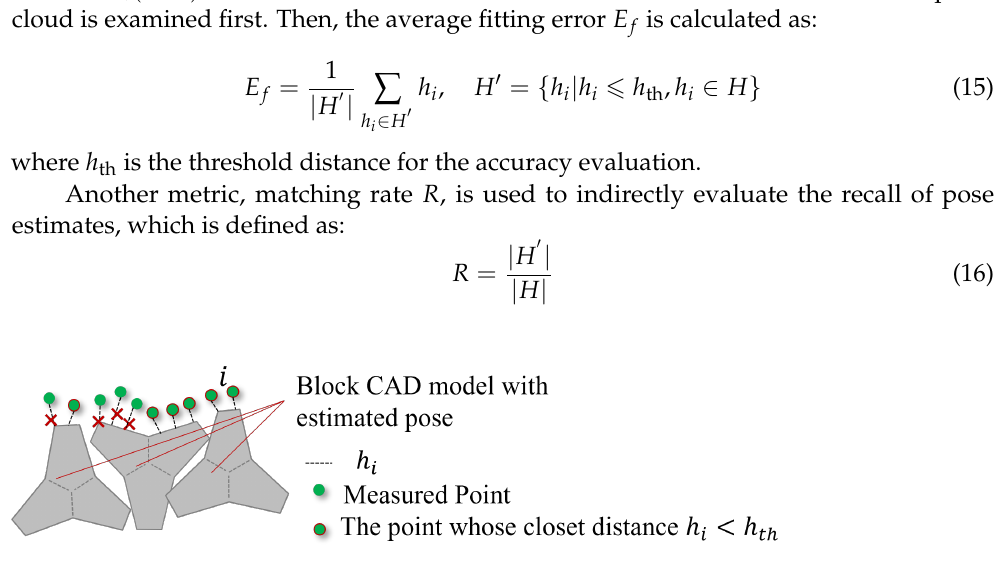
Figure 15. Average fitting error for block pose estimation.